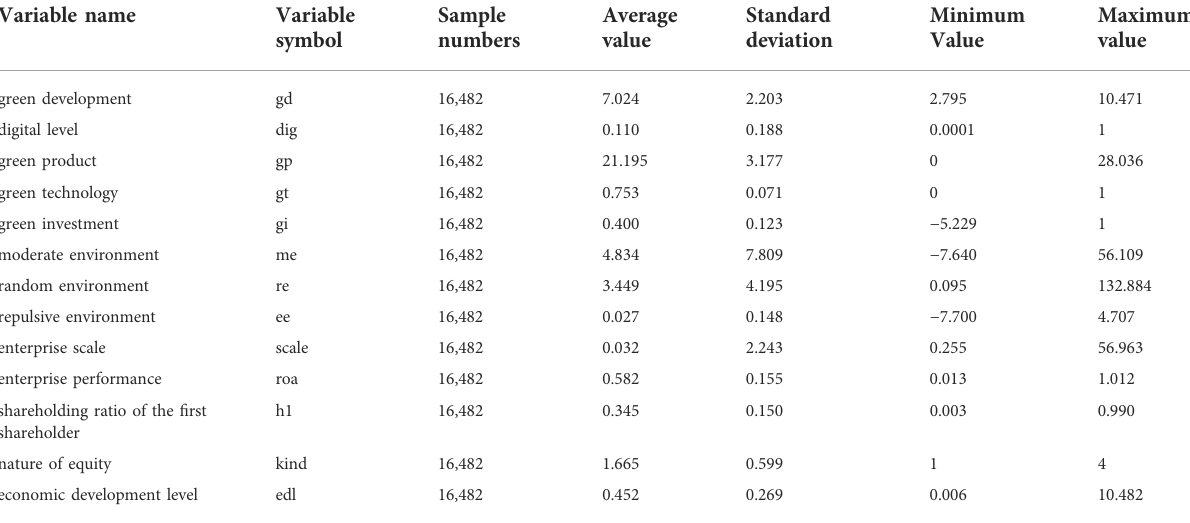
TABLE 1 Descriptive statistics of